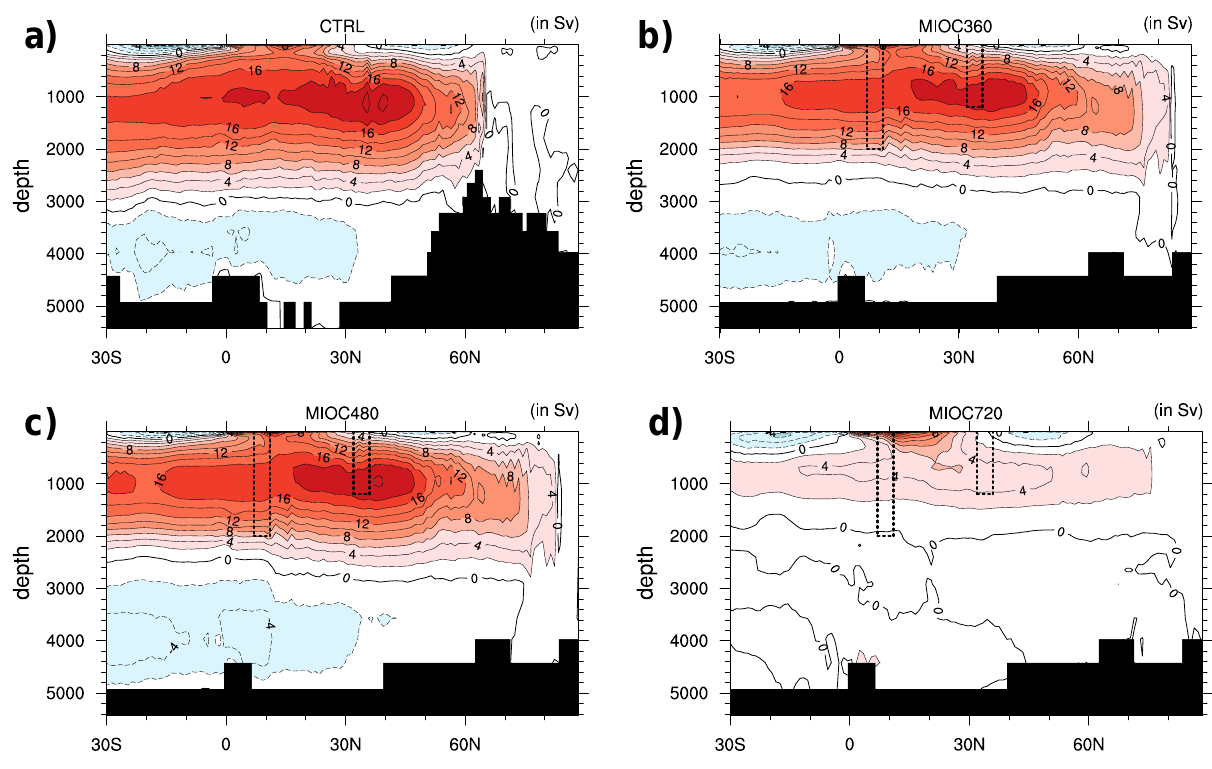
Fig. 10. Meridional overturning circulation in the Atlantic Ocean for (a) CTRL, (b) MIOC360, (c) MIOC480, and (d) MIOC720 (in Sv). Contour interval is 2Sv. Red corresponds to clockwise circulation; blue corresponds to anti-clockwise circulation. The rectangular boxes indicate the Middle Miocene ocean gateways: Panama Seaway at 10 ◦ N and Tethys Throughflow at 35 ◦ N. Note the subsided Greenland-Scotland Ridge for the Middle Miocene experiments.